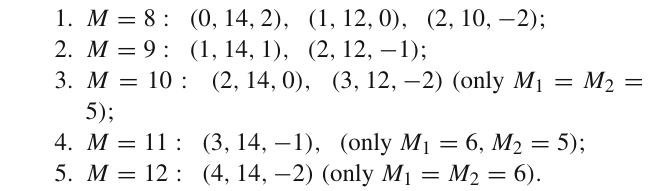
above. It is trivial to show that they all do not give any con- tribution to the inclusive cross-section in the domain (13) on the same grounds as for hA